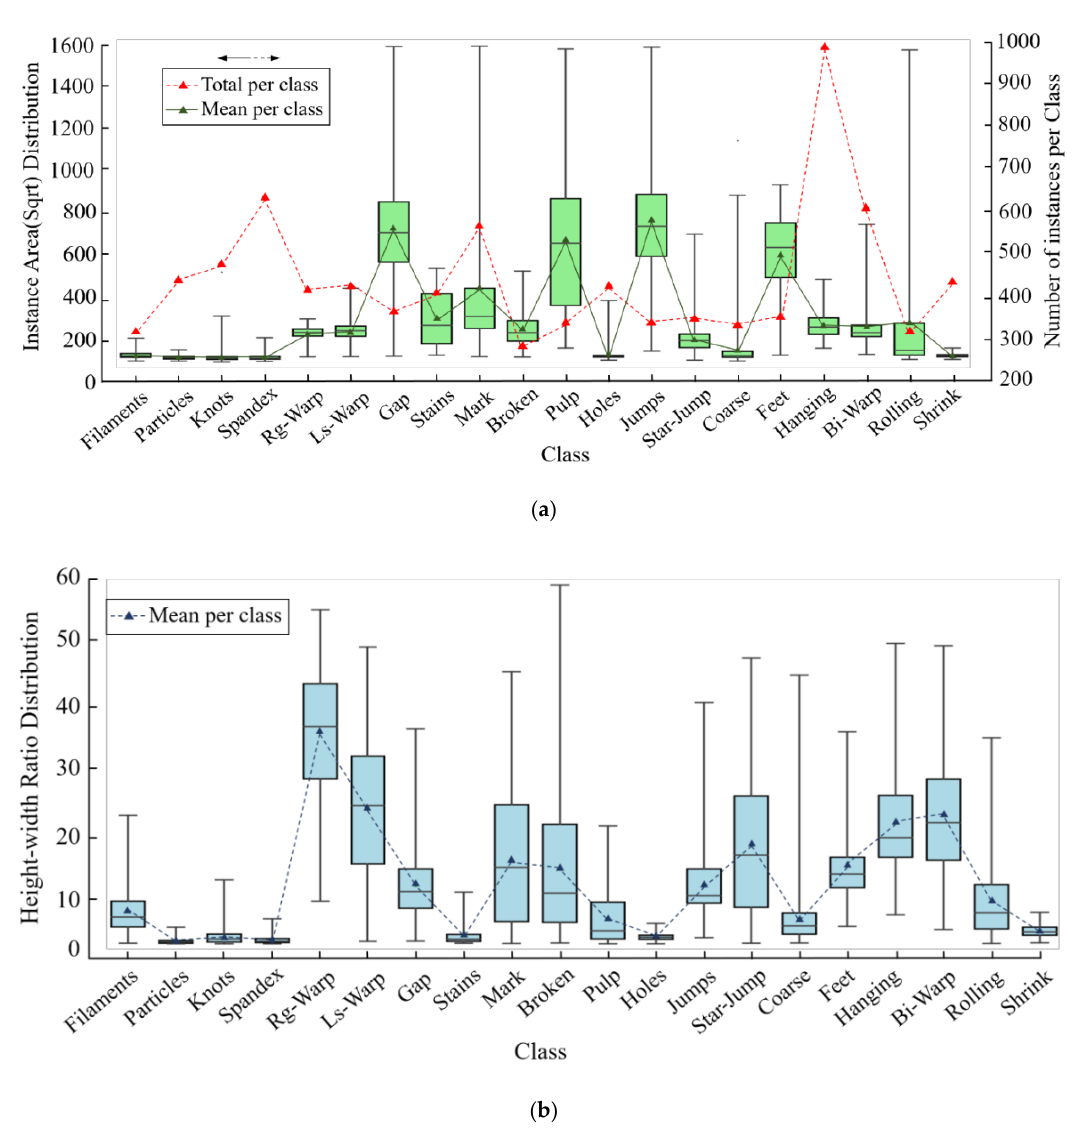
Figure 1. Imbalance distribution of instances for FBDF. ( a ) Area and number distribution of instances per class. ( b ) Size ratio distribution of bounding boxes per class.